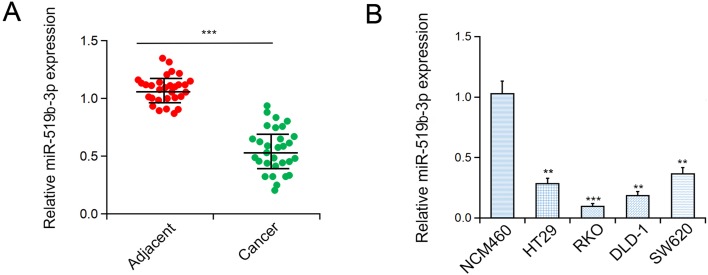
miR-519b-3p expression was down-regulated in colorectal cancer (CRC). (A) Relative expression of miR-519b-3p in CRC tissues and surrounding non-cancerous tissues were detected by qRT-PCR. **p < 0.01 vs. Adjacent. (B) Relative expression of miR-519b-3p in CRC cell lines (HT29, RKO, DLD-1, and SW620) and normal colon mucosal epithelial cells NCM460 was measured by qRT-PCR. **p < 0.01, ***p < 0.001 vs. NCM460.